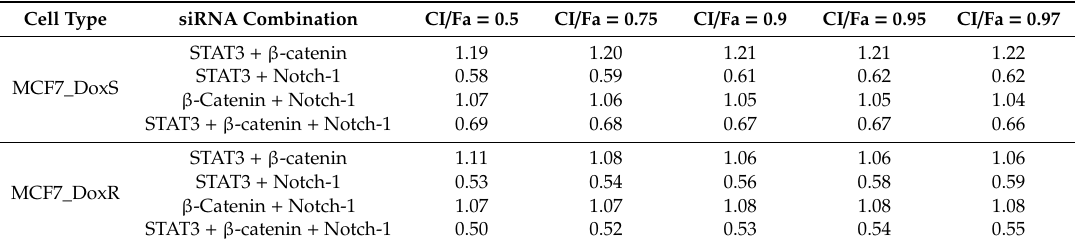
Table 2. Combination index (CI). Summary of fractional activity (Fa) at di ff erent points in the MCF7_DoxS cells and MCF7_DoxR cells. Cells were treated with di ff erent combinations of siRNA for 72 h and the combination index was calculated using Compusyn